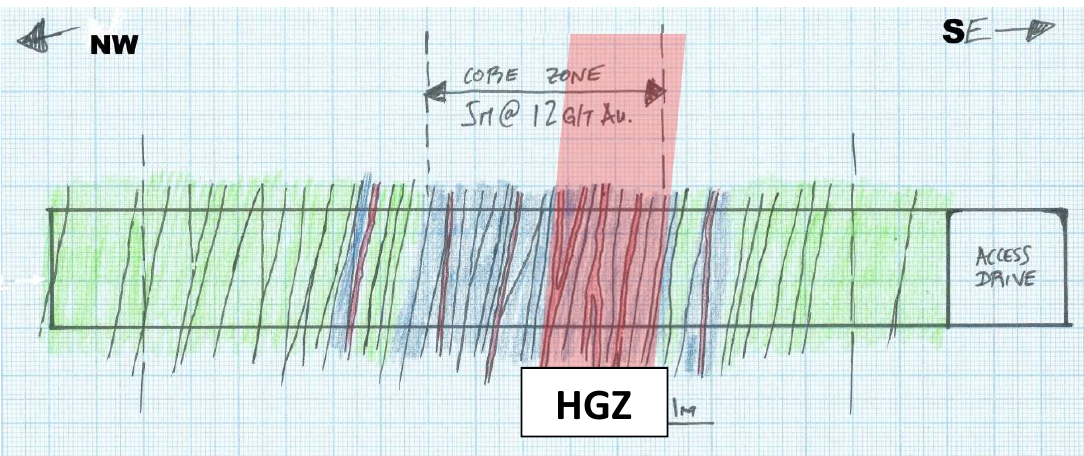
Figure 7. HGZ (2.6 m width at 19.1 g/t Au) identified within the CZ. Geological field sketch of cross-cut #2 (XC.2; Figure 2) NE wall. Green: weak to moderate silicification; and Blue: strong silicification.